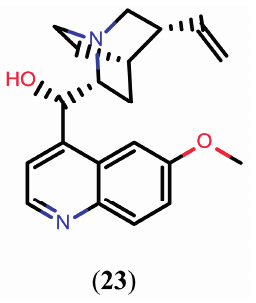
Figure 5. Chemical structure of